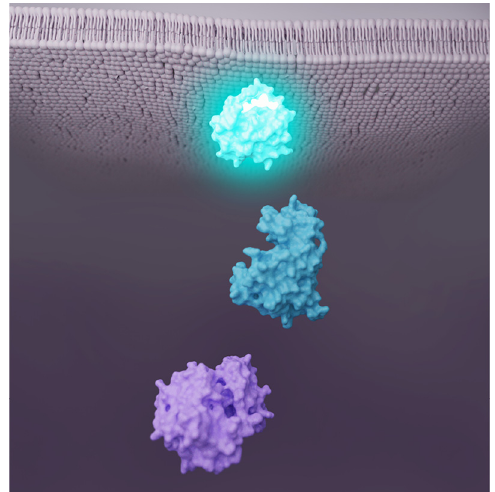
Figure 2: Simple biomedical illustration depicting key molecules in a